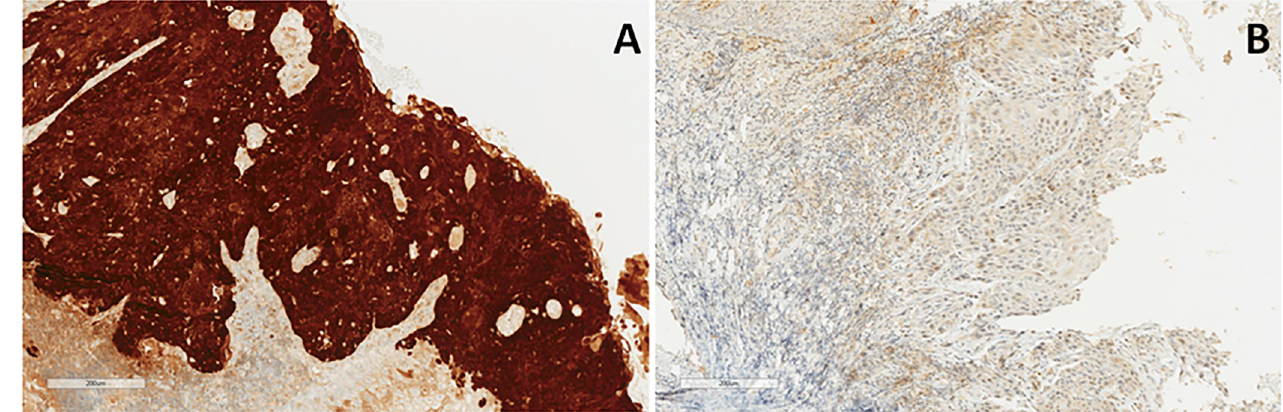
Fig 1. Representative photomicrograph of p16 expression (immunohistochemistry). 10x magnification. A: Oropharynx squamous cell carcinomawith p16-positive immunohistochemistry. B: Oropharynx squamous cell carcinomawith p16-negative immunohistochemistry.